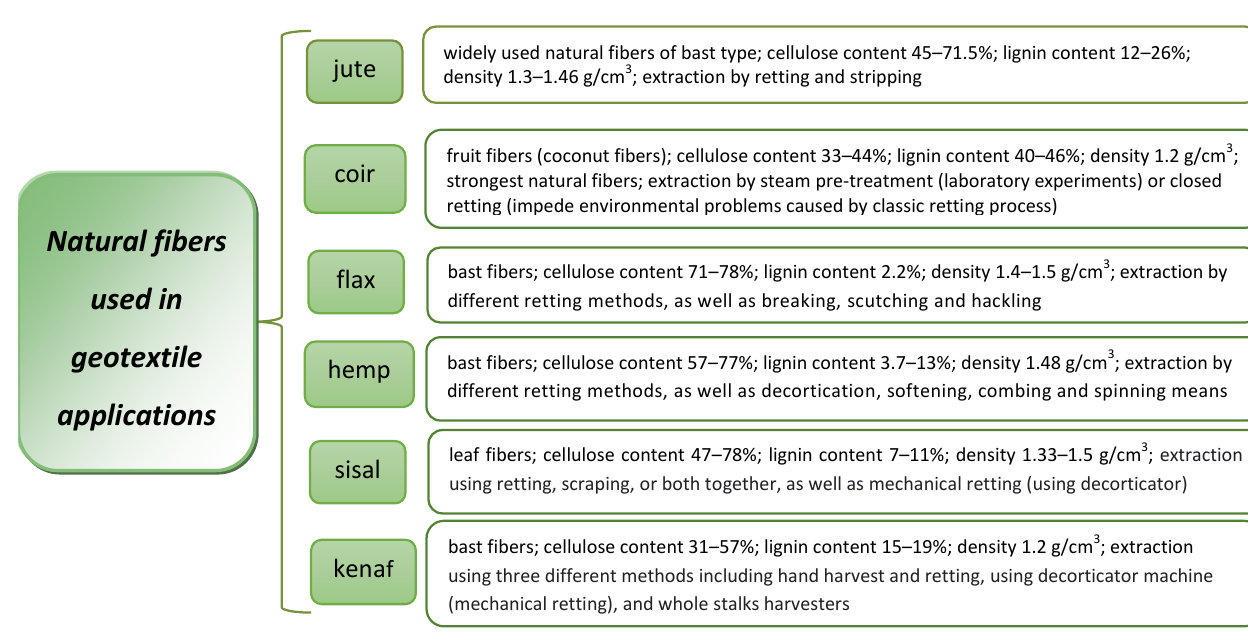
Figure 1. Most applicable natural fibers from plants for geotextile purposes.